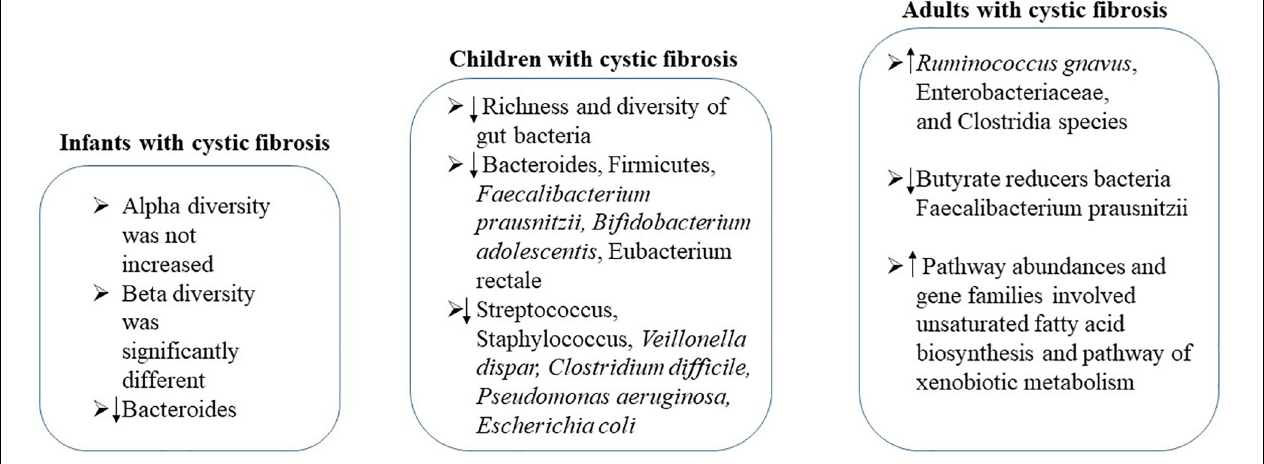
FIGURE 4 | The changes of gstrointestinal microbiota in cystic fibrosis patients at different